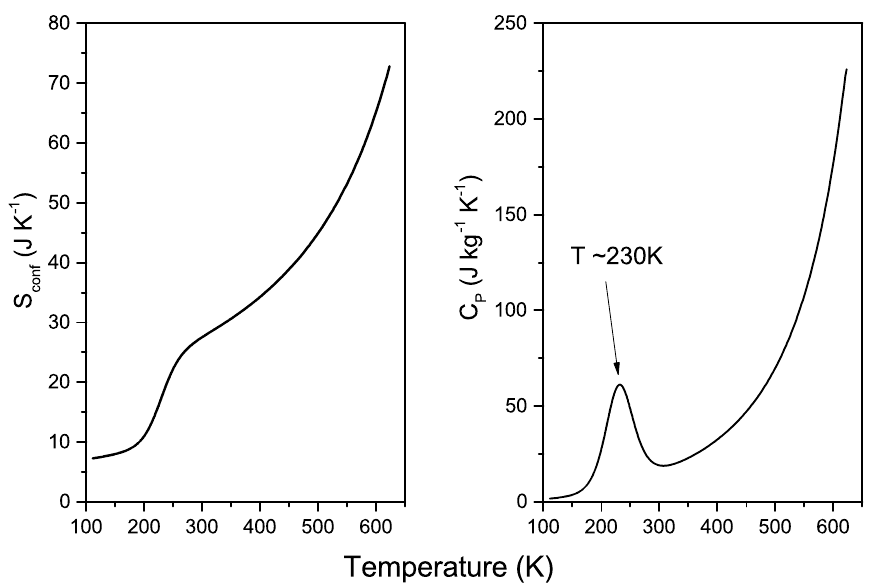
Figure 2. The configurational entropy contribution, obtained by means of the AG relation (Equa- tion (3)), applied to the two-states fitting of water self-diffusion ( left panel ). The corresponding configuration-specific heat, evaluated by using Equation (7) ( right panel